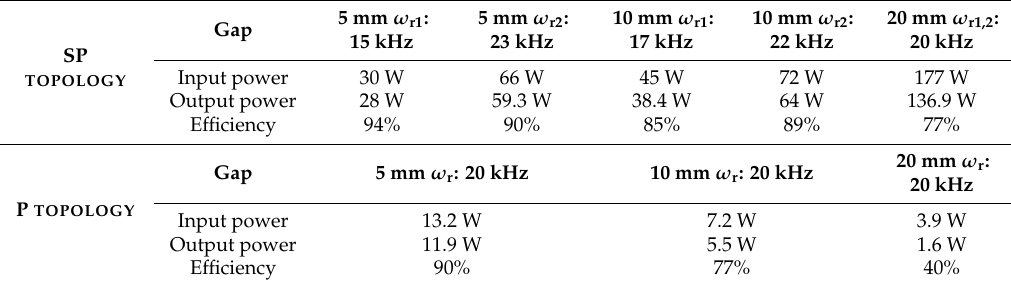
Table 2. Input power, output power, and efficiency of the IPT system.